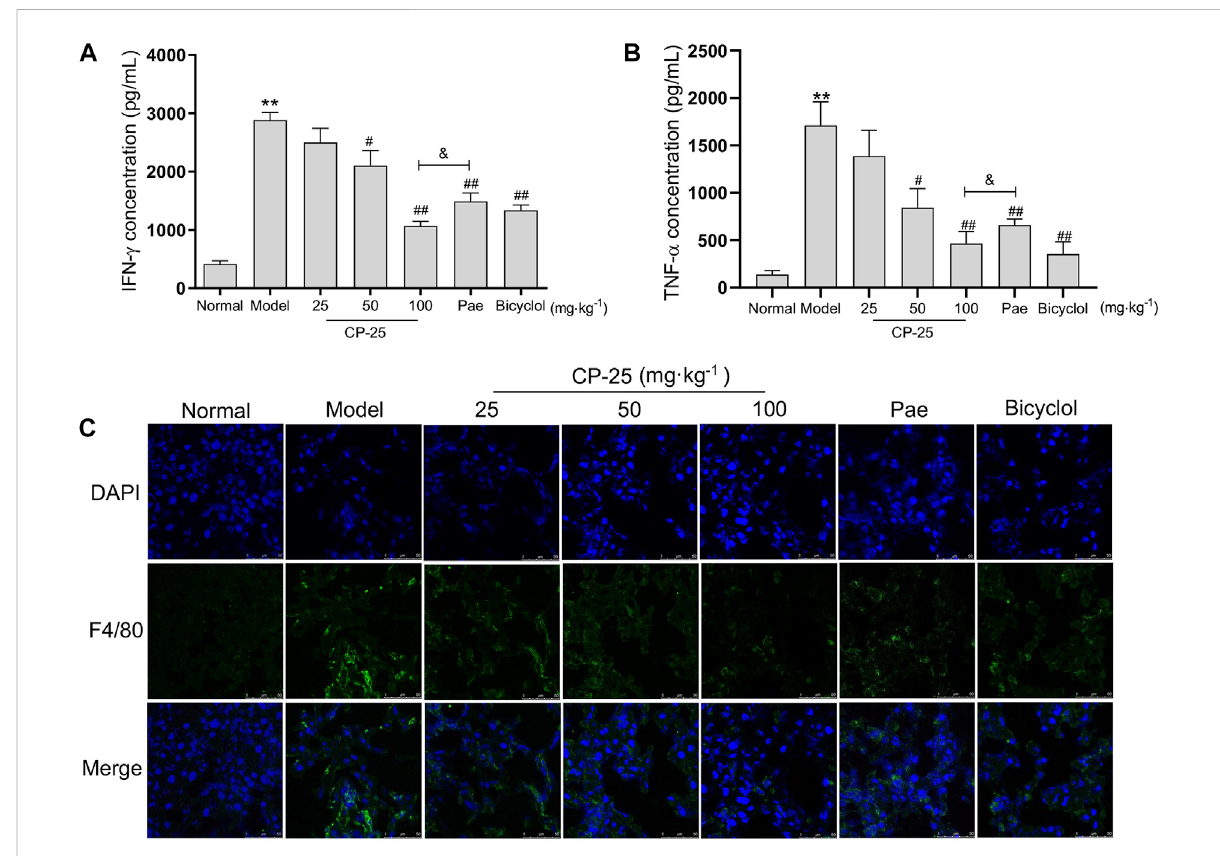
CP-25 down-regulated the in fl ammatory cytokines release in ConA-induced hepatitis. Comparison in fl ammatory factor expressions of IFN- γ (A) and TNF- α (B) in liver homogenate by ELISA. (C) Representative images showed the F4/80 positive staining cells (green) in liver sections